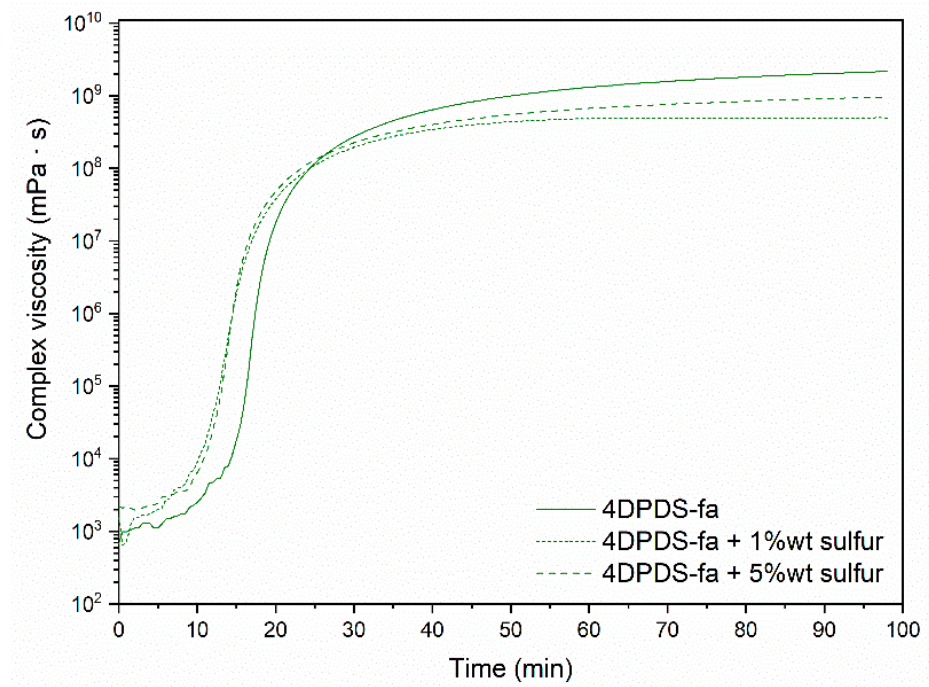
Figure A25. Curing behavior of 4DPDS-fa with 0, 1, and 5 %wt of sulfur by rheo-kinetics measurement at 150 °C followed by complex viscosity over time.